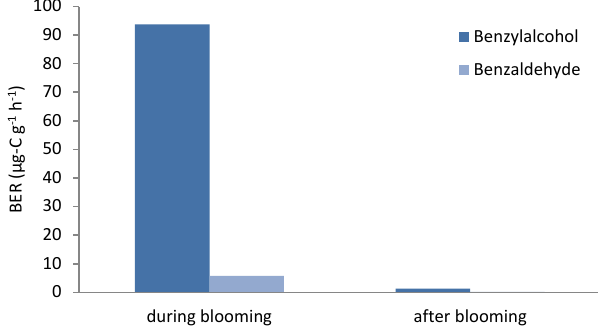
Fig. 5. Comparison of basal emission rates (30 ◦ C) of benzylalco- hol and benzaldehyde from crabapple before and after the flowering